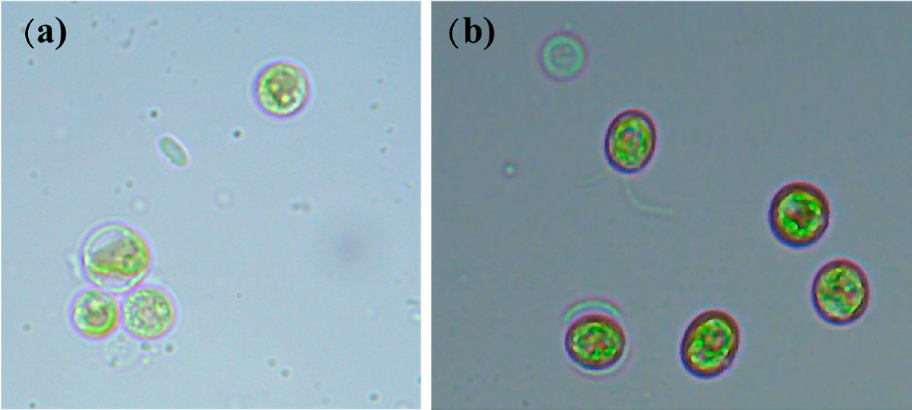
Figure 1. Microalgae strains ( a ) Chlorella sp. and ( b ) Chlamydomonas